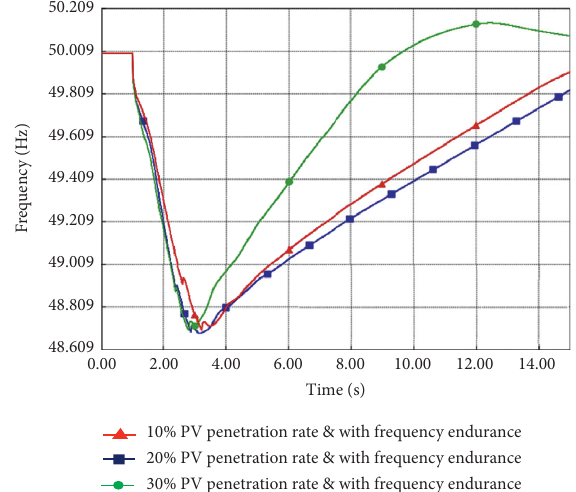
Figure 7: Frequency response under different penetration rates when all the distributed photovoltaic generations have frequency endurance capabilities.